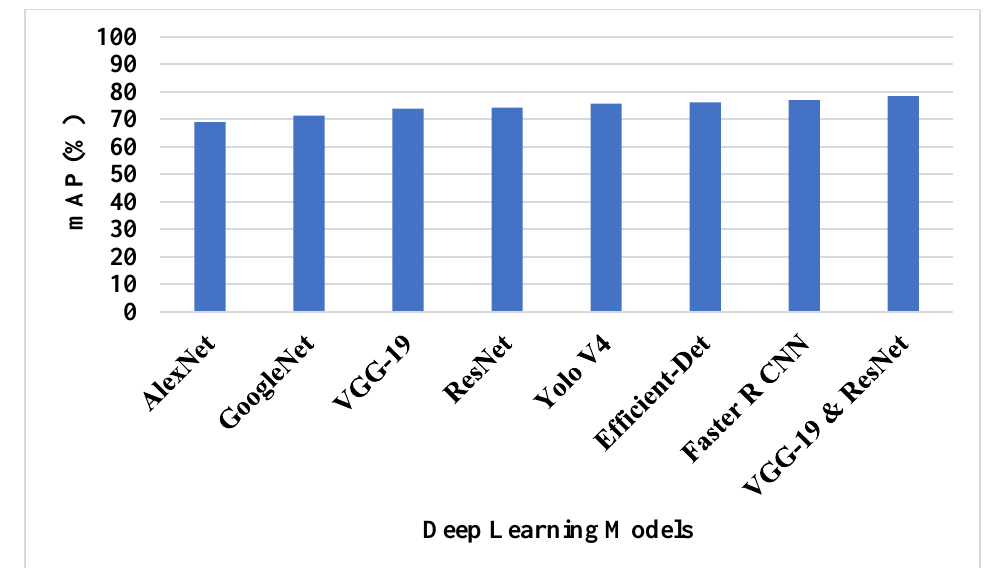
Figure 8. The mAP of deep learning techniques on DIOR dataset.